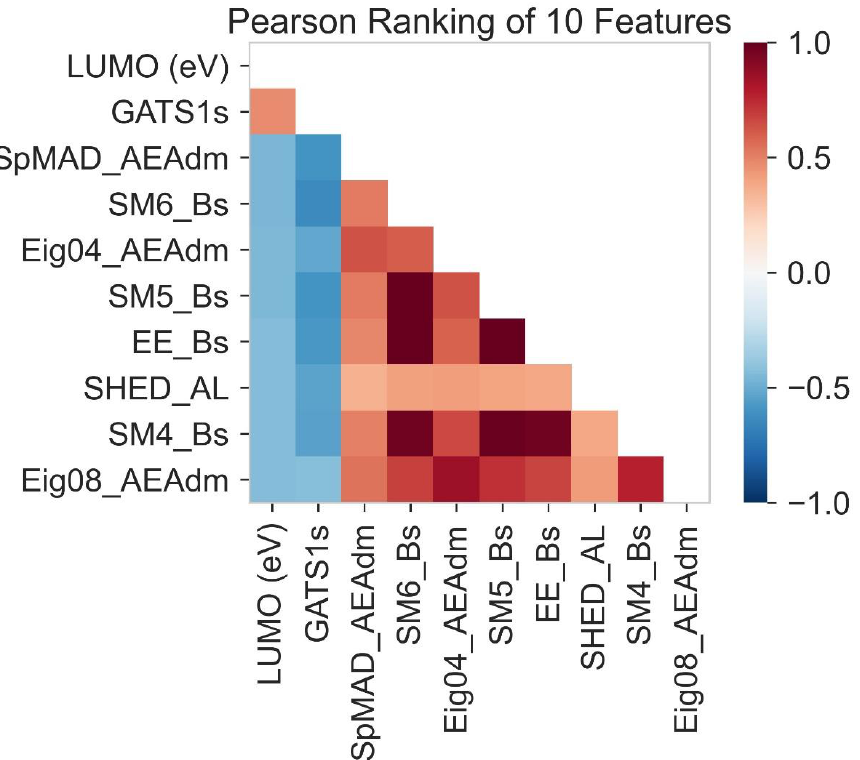
Figure 9. Correlation between LUMO and molecular descriptors. Table 3. Molecular descriptors with respective categories and descriptions.